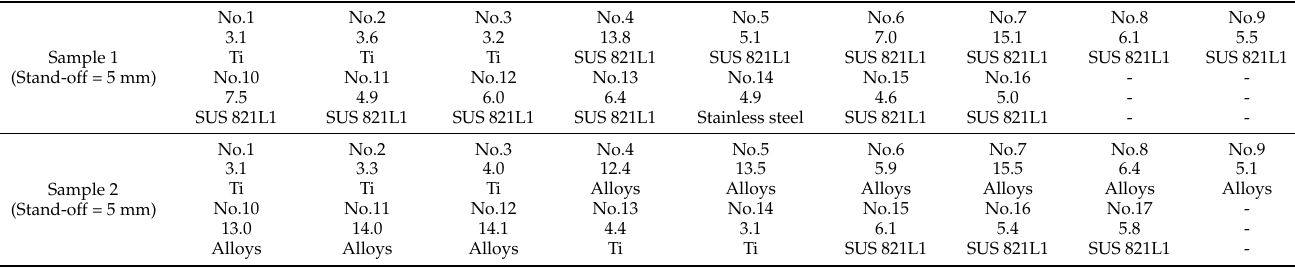
Table 2. Nanoindentation hardness (Unit: